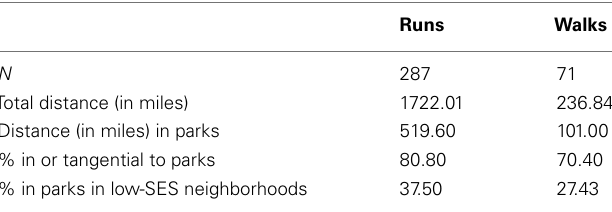
Table 1 | Use of parks in St. Louis, MO, USA for physical activity in 2012 a